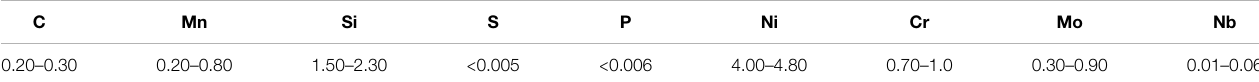
TABLE 1 | Chemical composition of G50 steel in wt%.